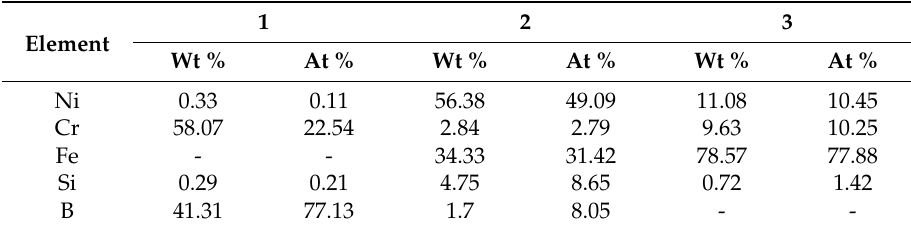
Table 1. The chemical compositions labeled 1,2,3 in Figure 3a.